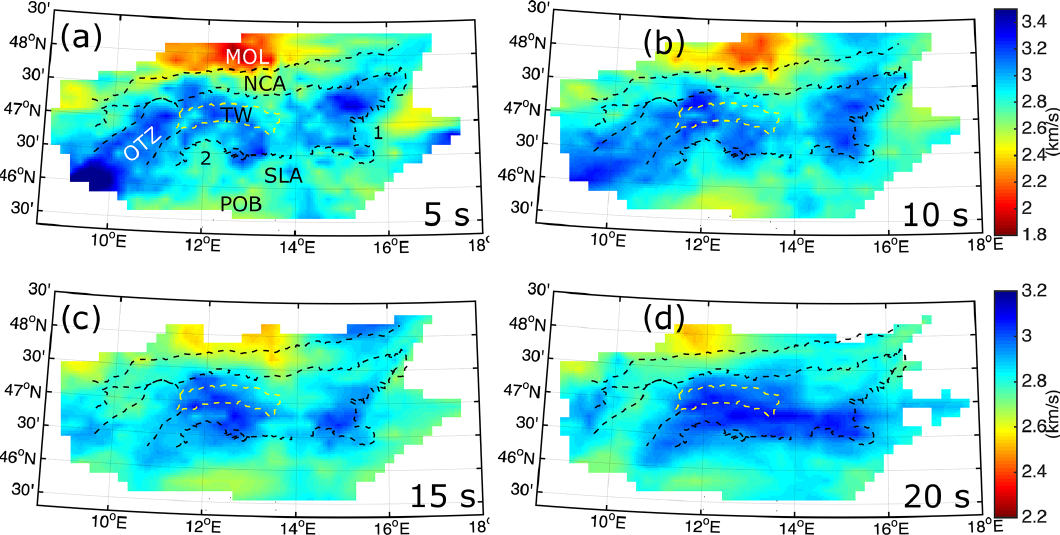
Figure 8. The obtained Rayleigh-wave group velocity maps at periods of 5, 10, 15, and 20s. Dashed lines (Egger et al., 1999; Schmid et al., 2004, see Fig. S4) represent the margins of the Northern Calcareous Alps (NCA), the crystalline core zone of the Alps (CZA), the Ötztal block (OTZ), and the Tauern Window (TW). The eastern margin of the CZA (no. 1 at 5s) and the northern margin of the Southern Limestone Alps (SLA; no. 2 at 5s) are well-marked by the velocity contrast at 5s. MOL: Molasse Basin, POB: Po Basin. Group velocity maps at larger periods of 30 and 40s are presented in Supplement Fig. S5.